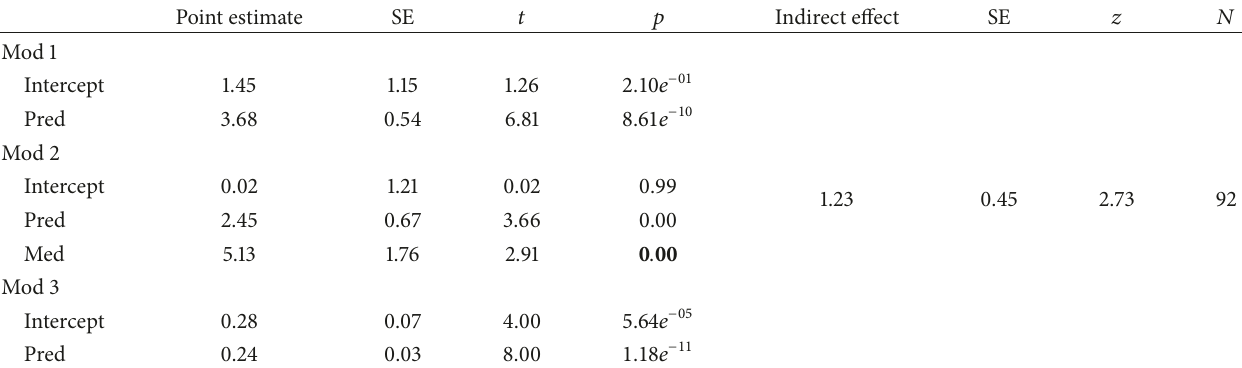
Table 5: Mediation analysis of the directional similarity as mediator of the relationship between simplicity of information structure and the number of clicks.